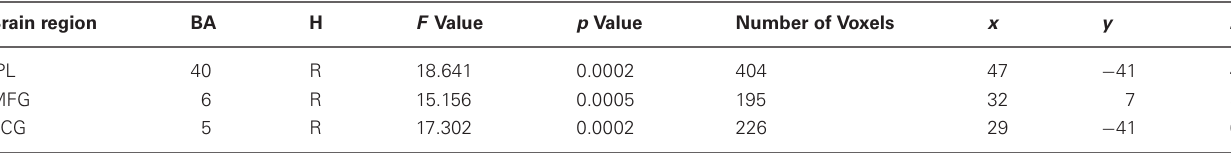
Table 1B | Brain regions activated in the voxel-wise Time by Group Interaction for the visual transfer task. Brain